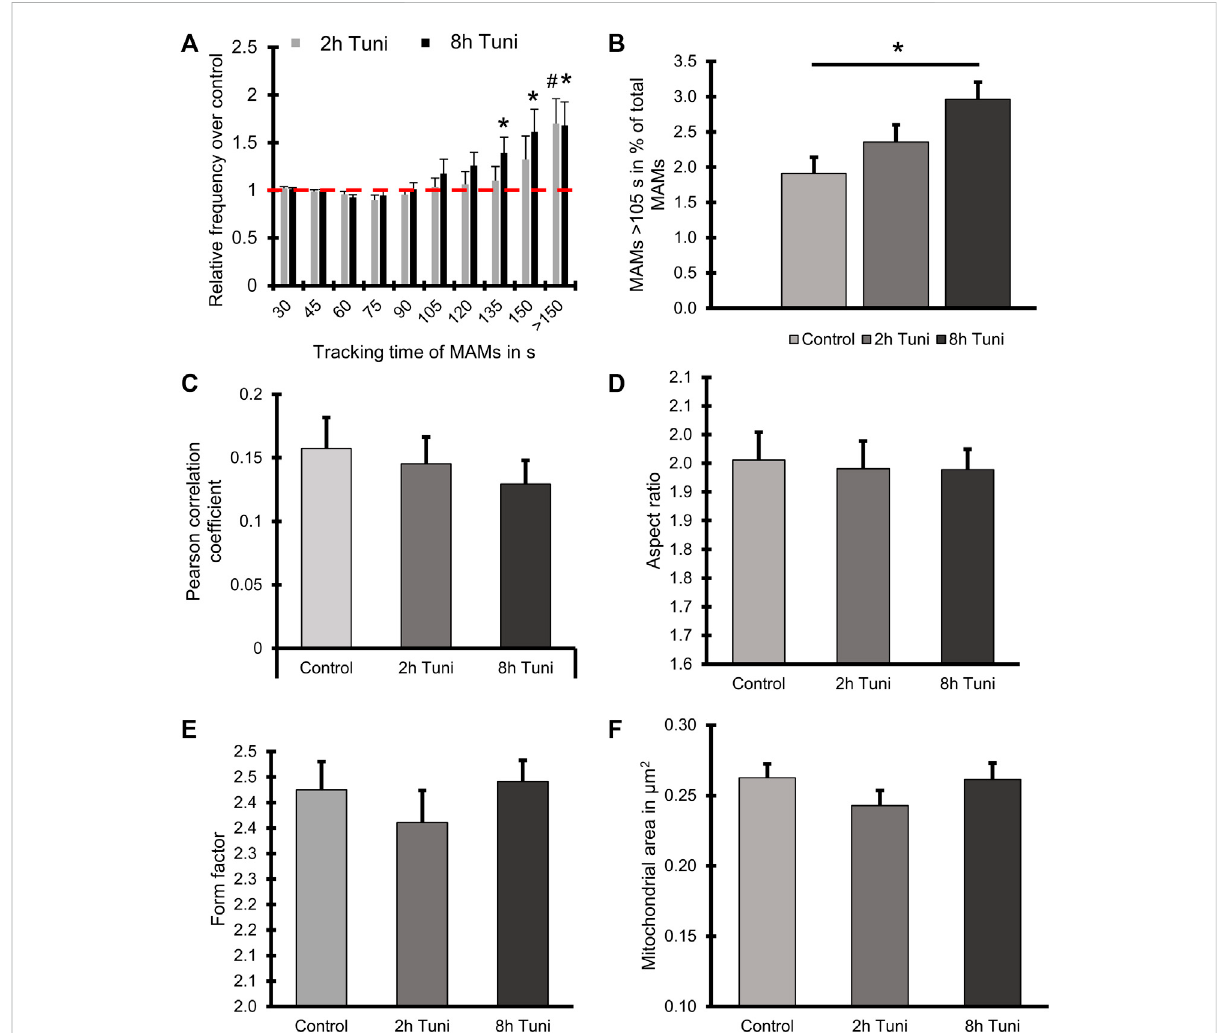
Tunicamycin treatment leads to prolonged ER-mitochondrial contacts but does not in fl uence ER-mitochondrial proximity or mitochondrial morphology. (A) HeLacellsexpressingtheERmarkerERAT4.01 NAwerelabeledwith100 nMTMRMand treatedwith0.6 µMtunicamycinfor twoor 8 hortherespectiveDMSOcontrol.TherelativefrequencyofMAMsisplottedoverthetrackingtimeofsingleMAMs. (B) Athresholdof105 stracking time was set to de fi ne long lasting MAMs and the percentage of MAMs included in that group was plotted as a bar graph (MEAN ± SEM) for cells treated with tunicamycin for two or 8 h or the respective DMSO control. (C) Bar graphs (MEAN ± SEM) shows Pearson ’ s correlation coef fi cient of controlHeLaorHeLacellstreatedwithtunicamycinfor2 hor8 h. (D) Bargraphs(MEAN±SEM)showsmitochondrialaspectratioofcontrolHeLaor HeLa cells treated with tunicamycin for 2 h or 8 h. (E) Bar graphs (MEAN ± SEM) shows mitochondrial form factor of control HeLa or HeLa cells treatedwithtunicamycinfor2 hor8 h. (F)